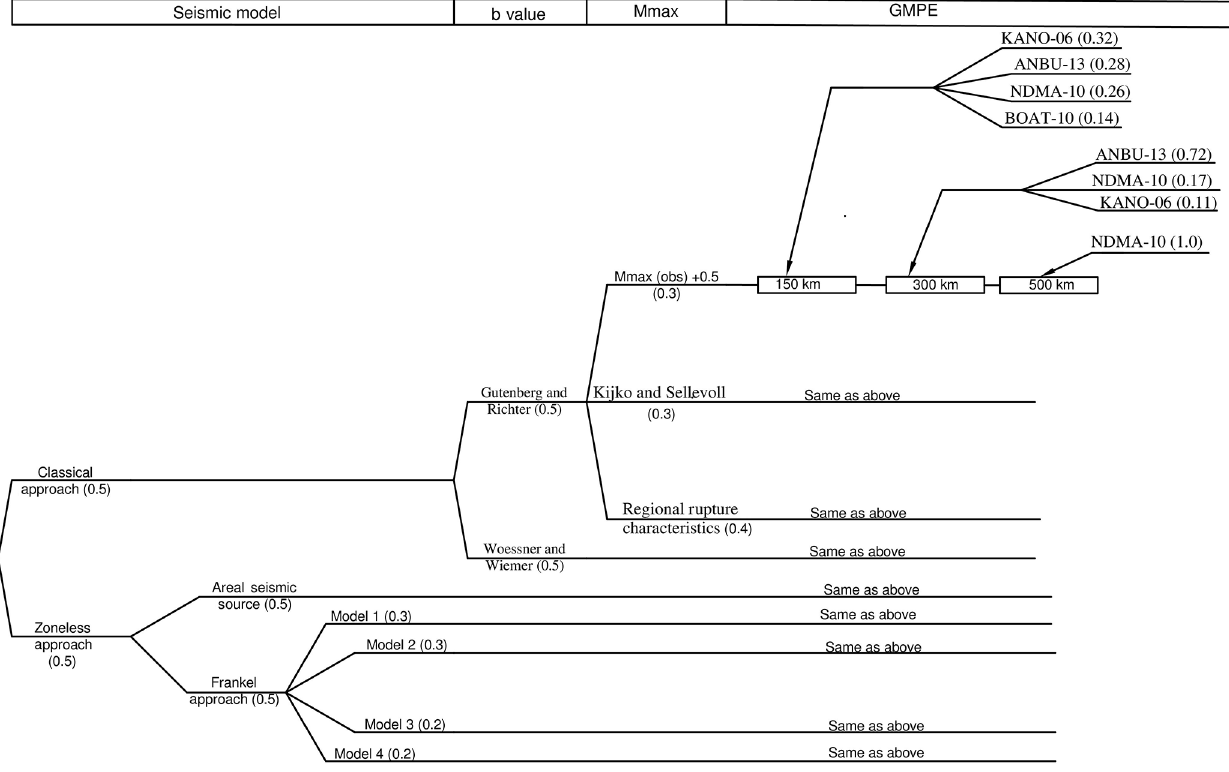
grid for Patna, and the level of ground motion for ν(z)